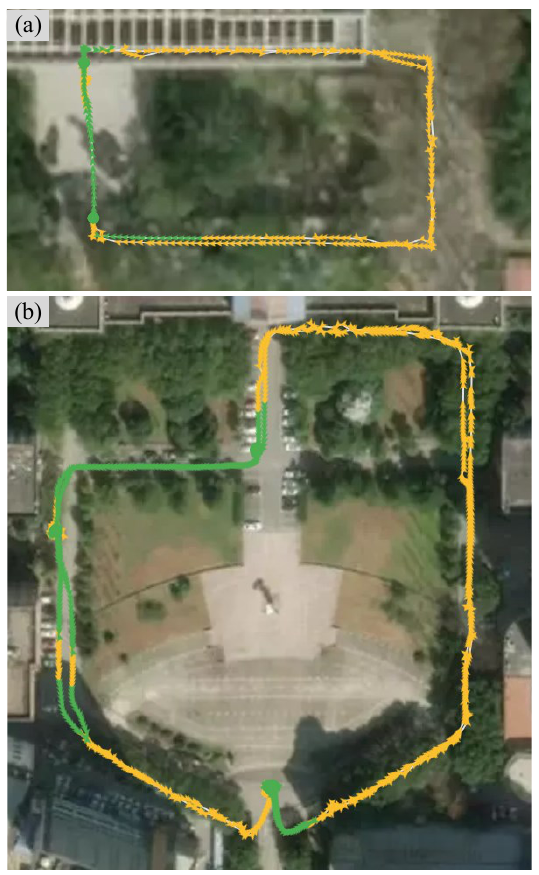
Figure 3: Two RTK tracks of our experimental results, on which the yellow parts are float solutions, green parts are fixed solutions. (a) Track 1 is a two-round clockwise loop on Sept. 26, 2021; (b) Track 2 is a two-round counterclockwise loop on Oct. 27, 2021.